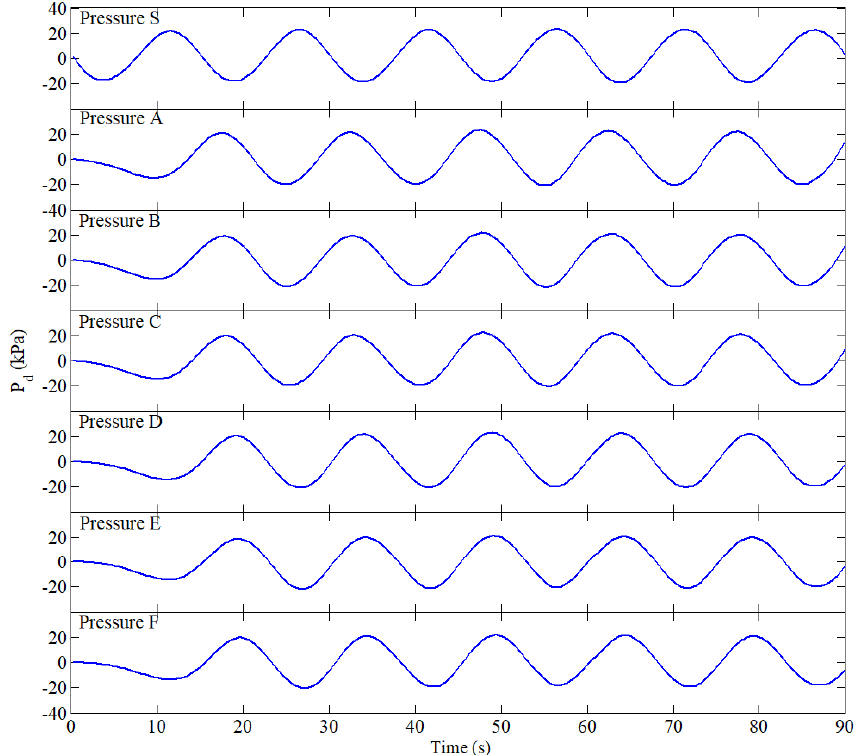
Figure 8. Time history of wave impact at different typical positions on the seabed surface in Case 1 ( H = 7 m, d = 50 m, T = 15 s).